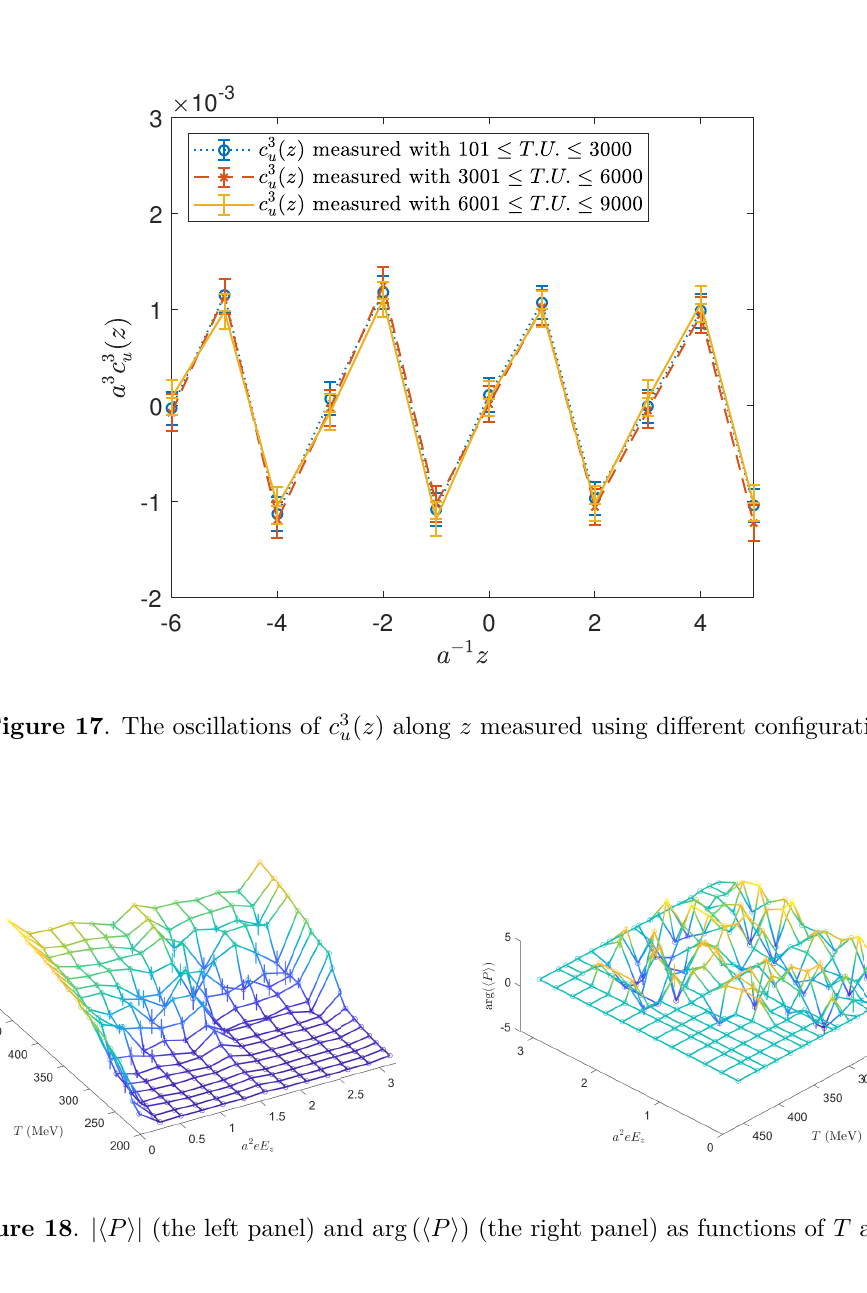
Figure 18 . |h P i| (the left panel) and arg ( h P i ) (the right panel) as functions of T and E z